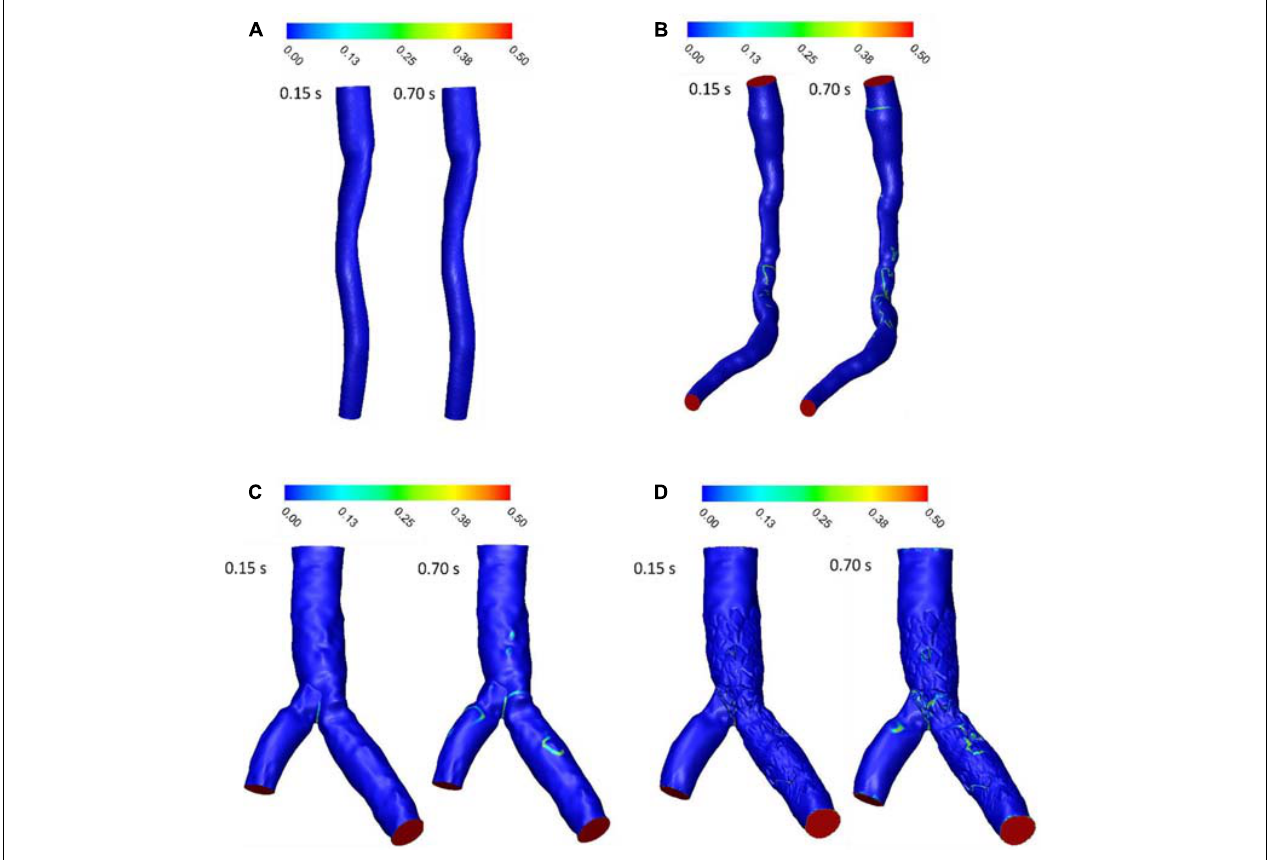
FIGURE 4 | OSI (A) for patient A, (B) for patient B, (C) for patient C without stent, and (D) with stent during both systole (0.15 s of pulse) and diastole (0.7 s of